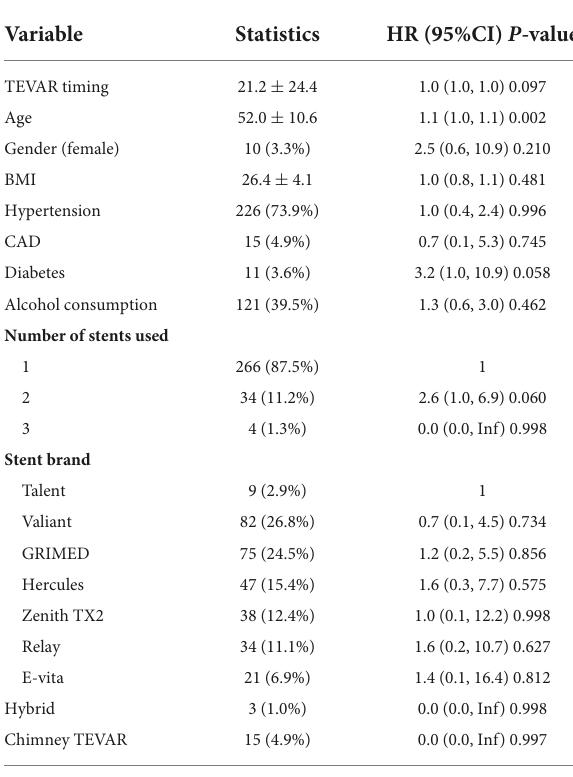
TABLE 2 Univariate analysis results.